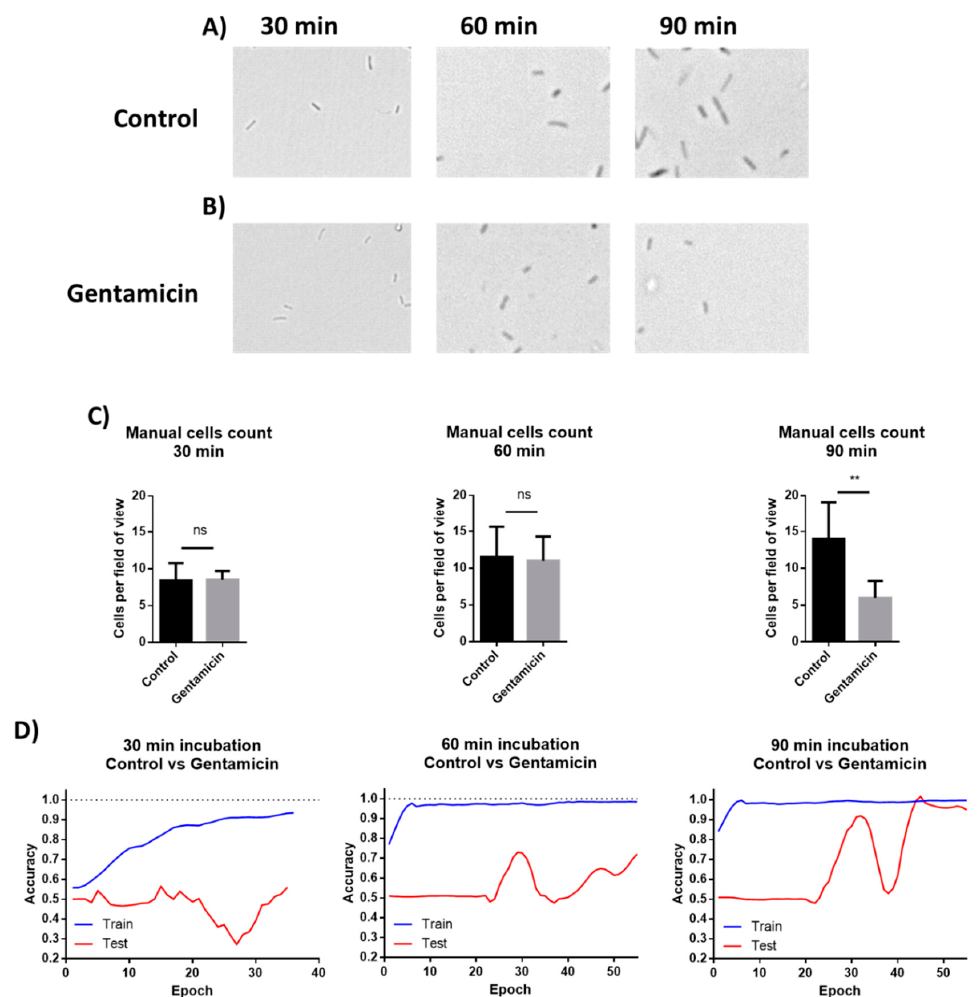
Figure 7. Manual cells counting and deep learning for AST. ( A ) E. coli cells were incubated without antibiotics for 30, 60, and 90 min. ( B ) Cells were incubated in wells with drop-dried antibiotic for 30, 60, and 90 min. ( C ) Manual counting of the cells after 30, 60 and 90 min of incubation. n = 8. Error bars indicate standard deviation. ( D ) Machine learning plots, as tested after 30, 60 and 90 min of incubation. ** P ≤